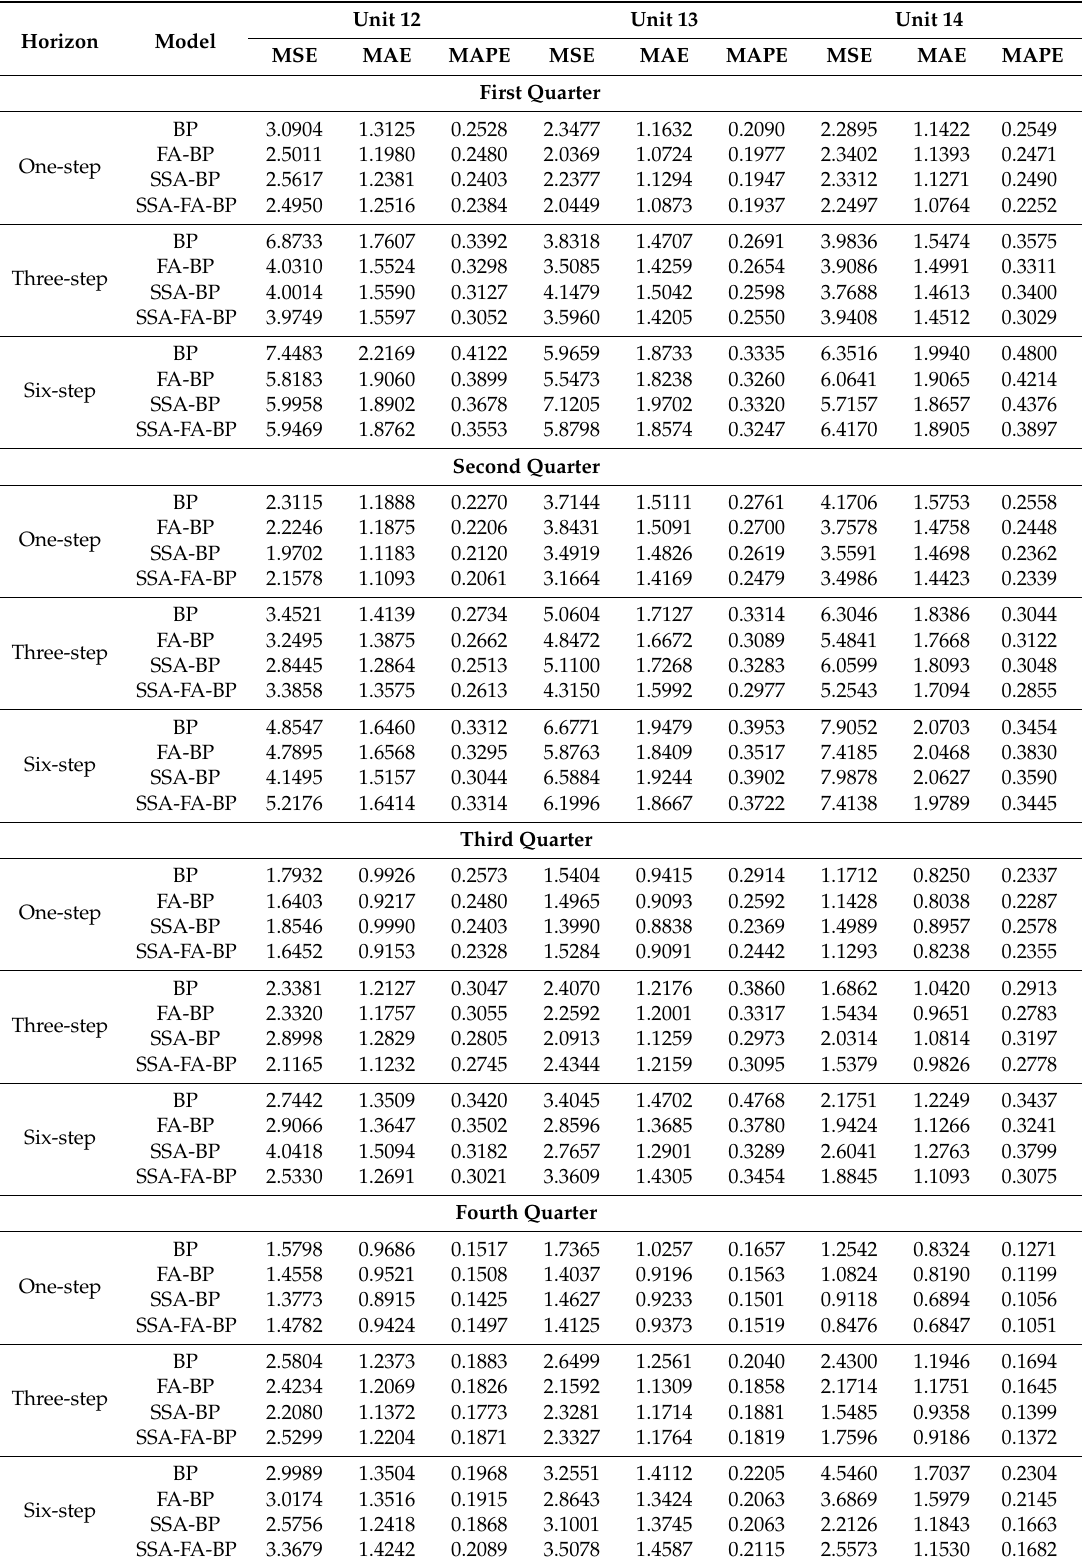
Table 8. The quarterly forecasting results of the combined model and the results of the other models involving the data of three units (60